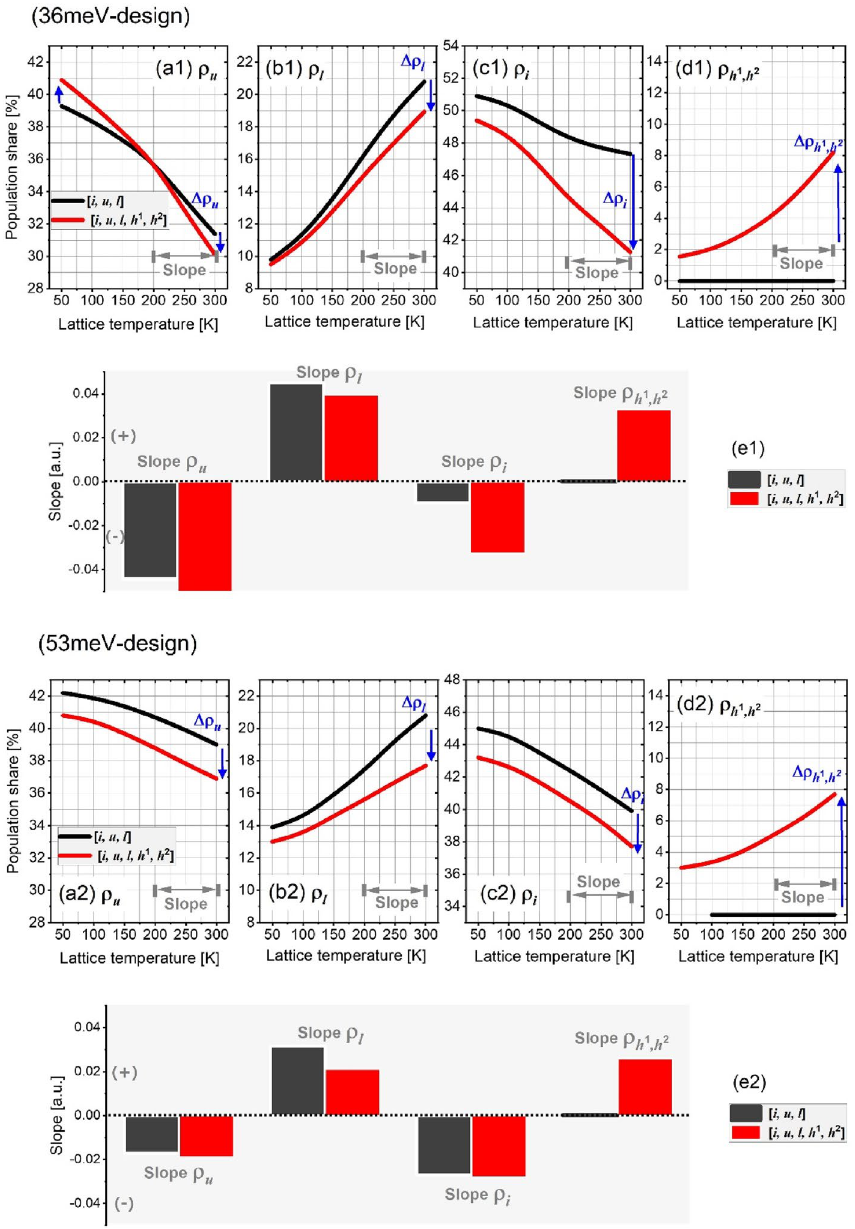
Figure 3. Population fractions at each subbands as a function of temperatures in both designs ( a1 – d1 , 36 meV- design; a2 – d2 , 53 meV-design). Here, ρ u , ρ l , and ρ i denote the fraction at upper-laser, lower-laser, and injector subbands, ρ h 1, h 2 is a sum of fractions at both the HLS, h 1 and h 2 . The black/red lines represent the small scale [ i , u , l ] and the full scale [ i , u , l , h 1 , h 2 ], respectively. ( e1 , e2 ) The changing slope of population fractions at high temperatures above 200 K. The black rectangles indicate the small scale [ i , u , l ] and the red rectangles is for a full scale [ i , u , l , h 1 , h 2 ]. The plus/minus slopes denote the increasing/decreasing changing trend at high temperatures above 200 K,